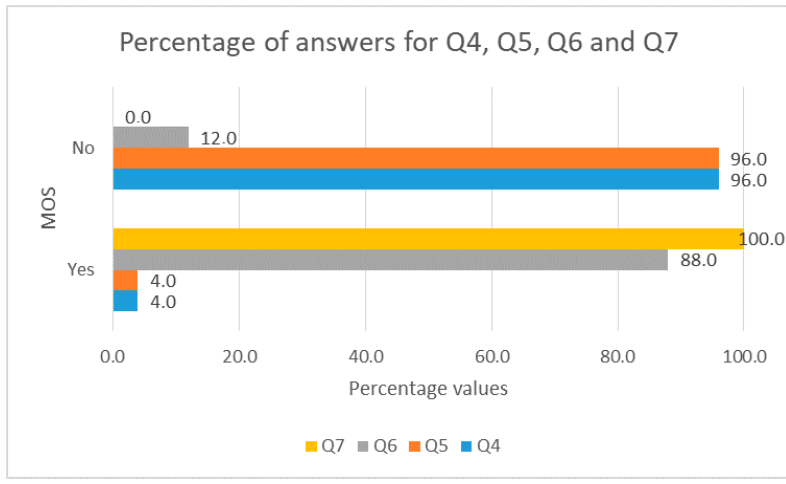
Figure 12. Percentages by categories of the MOS for Q4, Q5, Q6 and Q7.